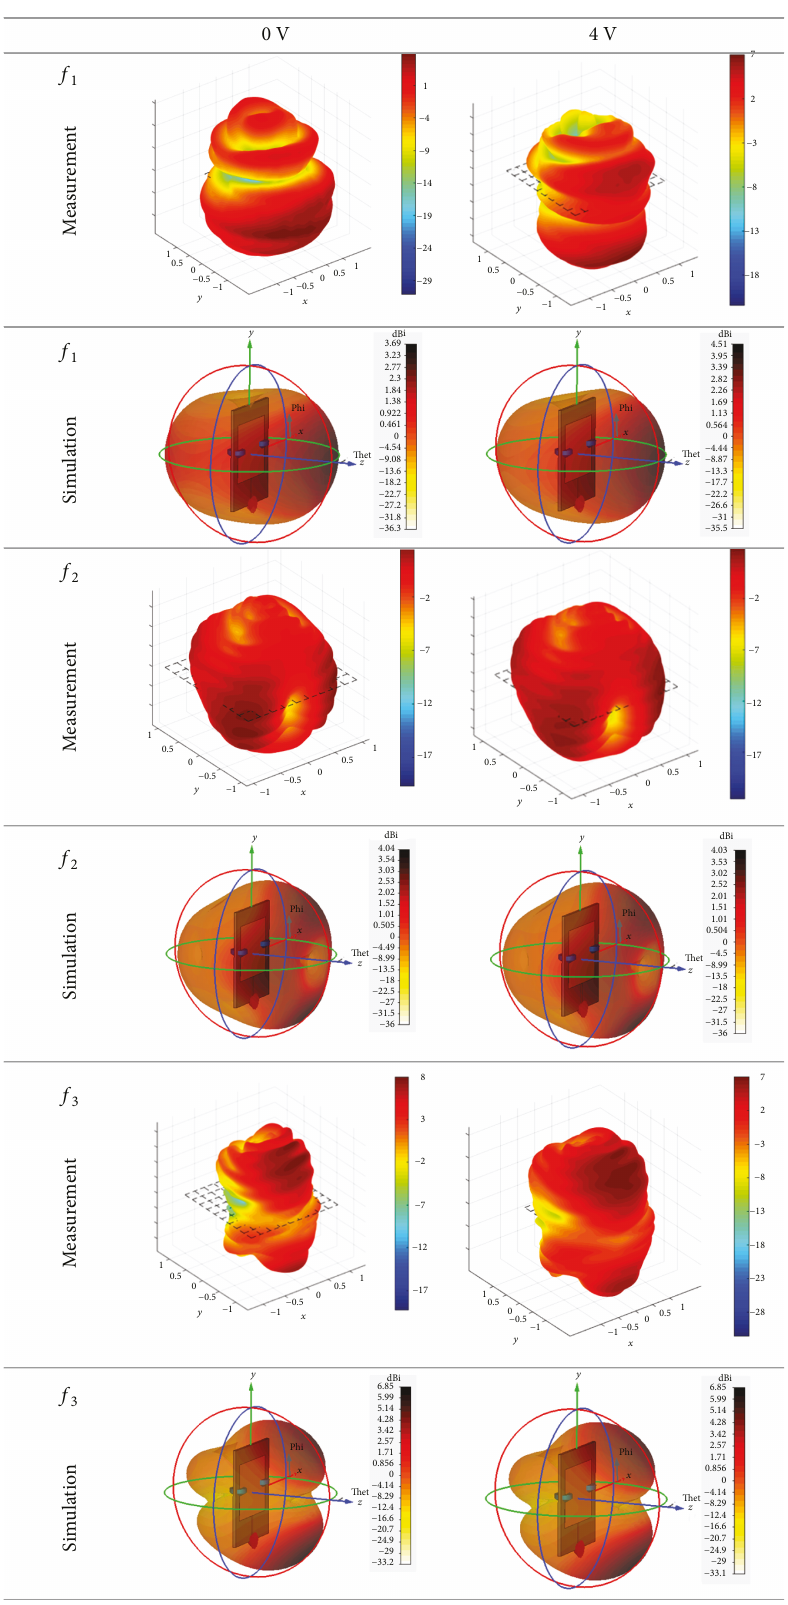
Figure 17: Simulated and measured 3D radiation